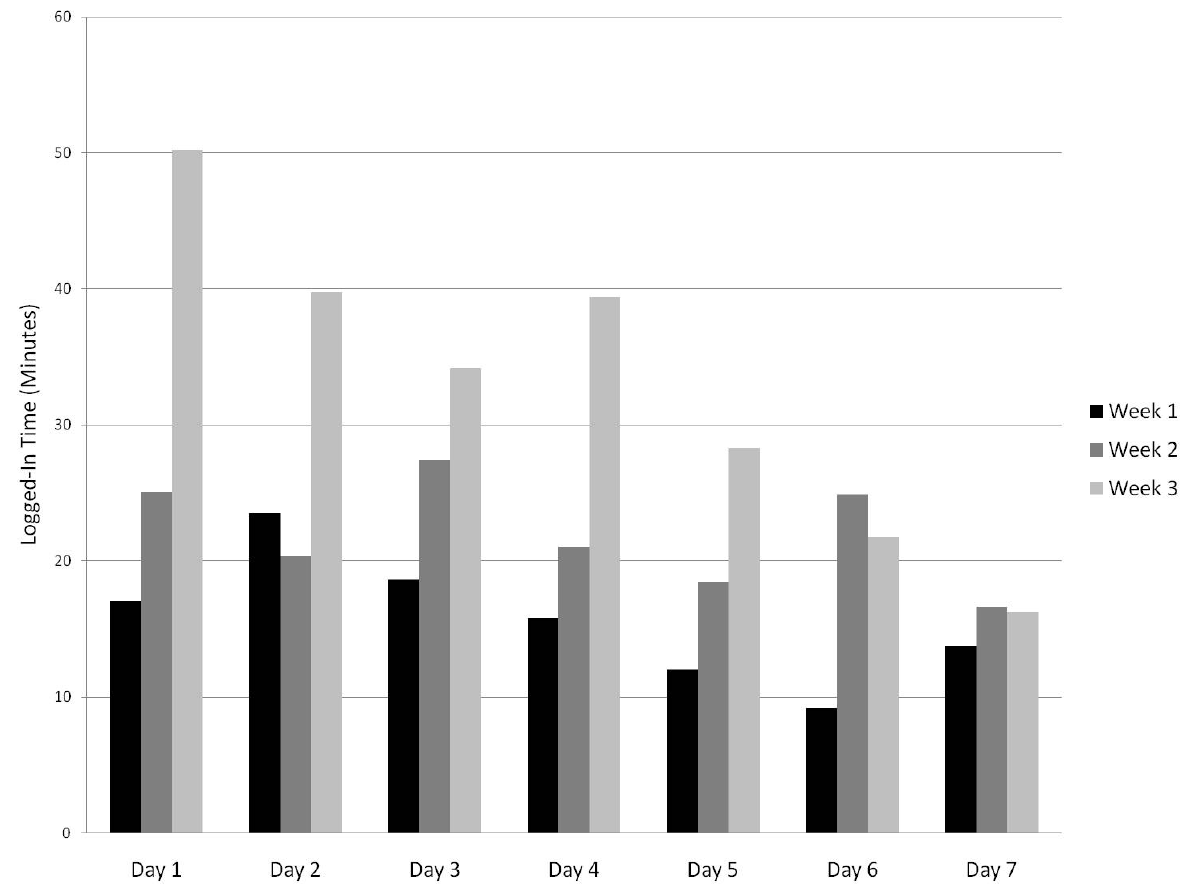
Figure 4. Mean logged-in time per participant per day, by